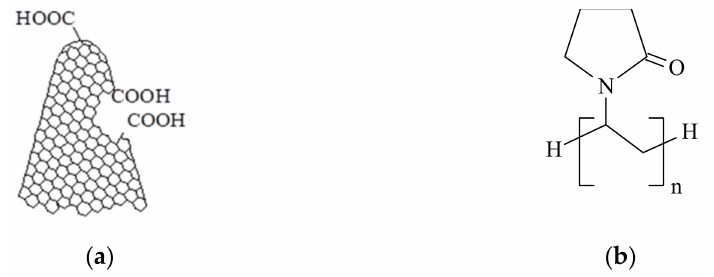
Figure 1. The structure of ( a ) CNHox and ( b )